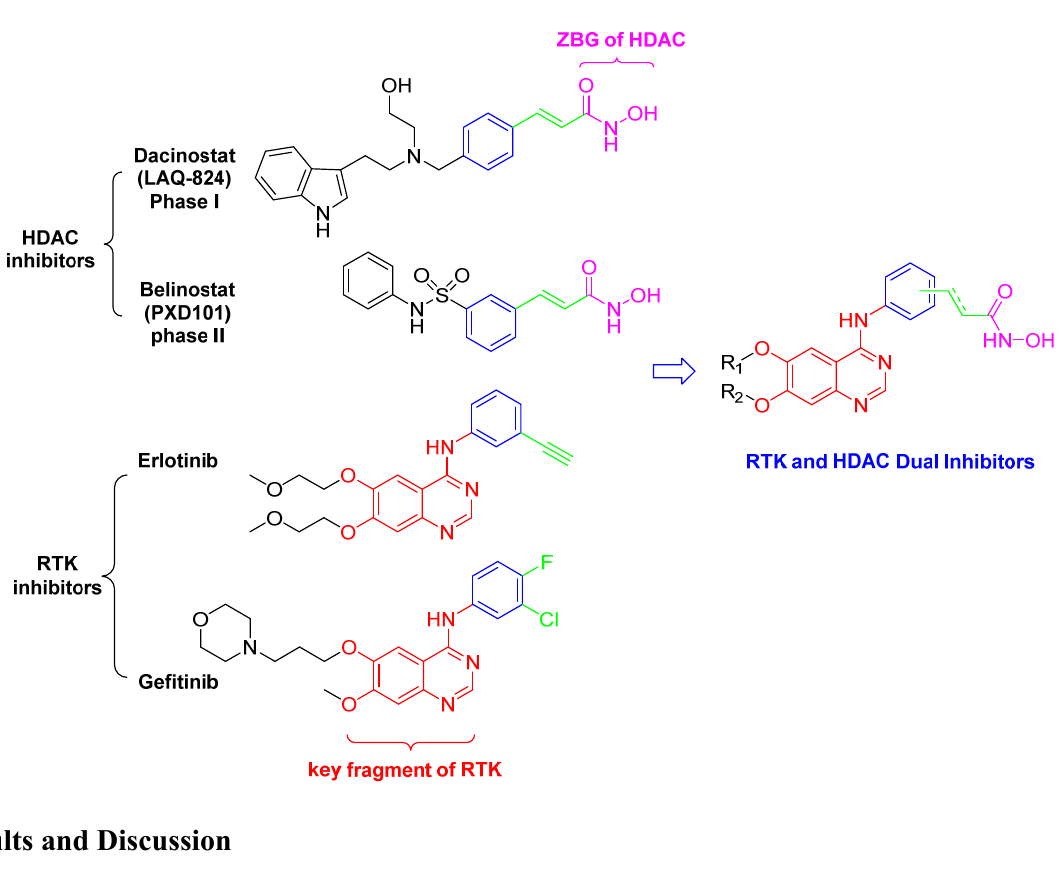
Figure 2. Design of dual inhibitors of RTK and